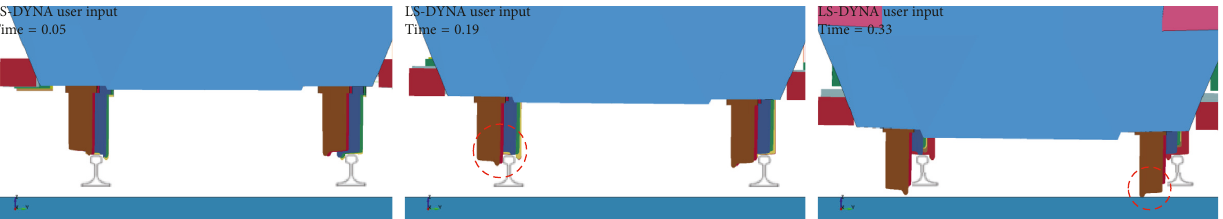
Figure 5: Derailment behavior by wheel climbing on simulation.